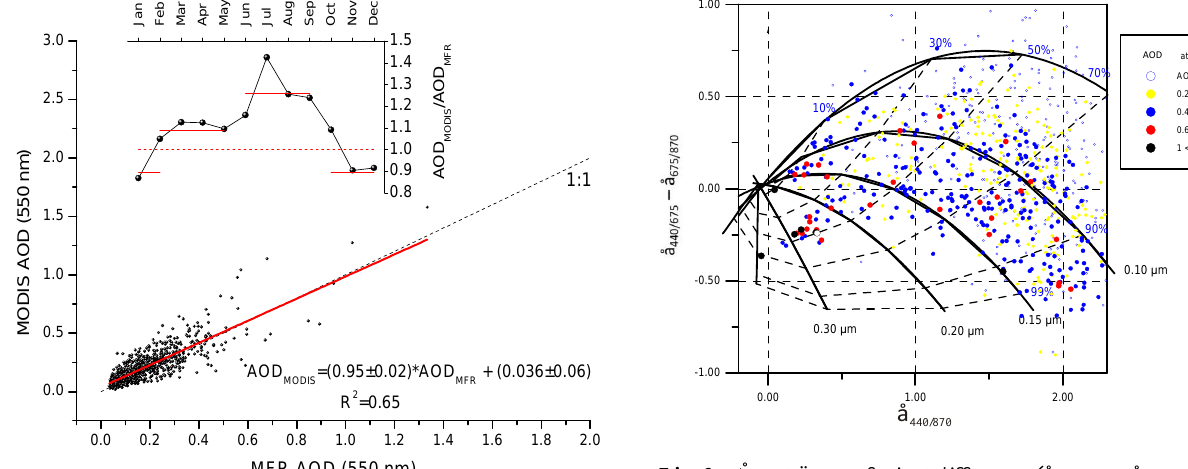
Fig. 9. ˚Angstr¨om coefficient difference (˚a 440 / 675 –˚a 675 / 870 ) as a Figure 9. Ångström coefficient difference (å 440/675 – å 675/870 ) as a function of å 440/870 function of ˚a 440 / 870 and AOD at 440nm over Athens, for bimodal, lognormal size distributions. The black solid lines account for a and AOD at 440 nm over Athens, for bimodal, lognormal size distributions. The black fixed effective radius ( R f ) of the fine mode and the dashed lines for solid lines account for a fixed effective radius (R f ) of the fine mode and the dashed a fixed fraction contribution ( η) of the fine mode to the lines for a fixed fraction contribution ( η ) of the fine mode to the AOD. /AOD MODIS MFR